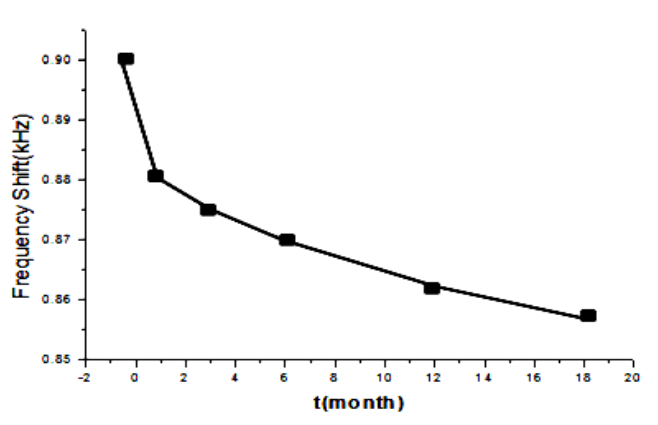
Figure 7. Stability study of MIP sensor.